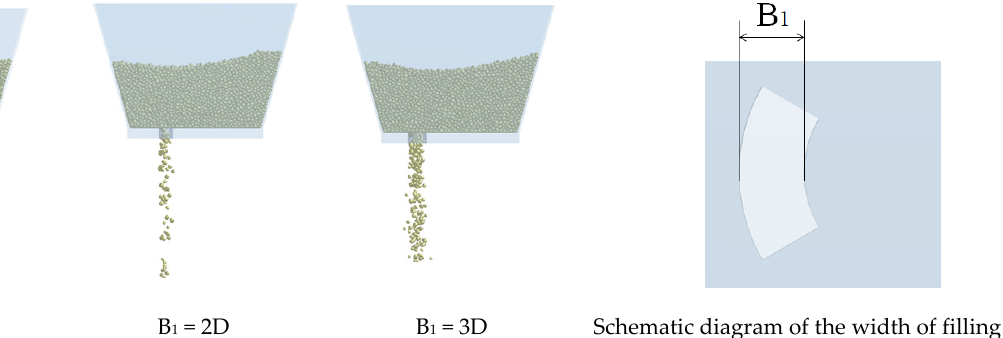
Figure 4. Simulation experiment of fertilizer discharge in different widths of organic fertilizer boxes.